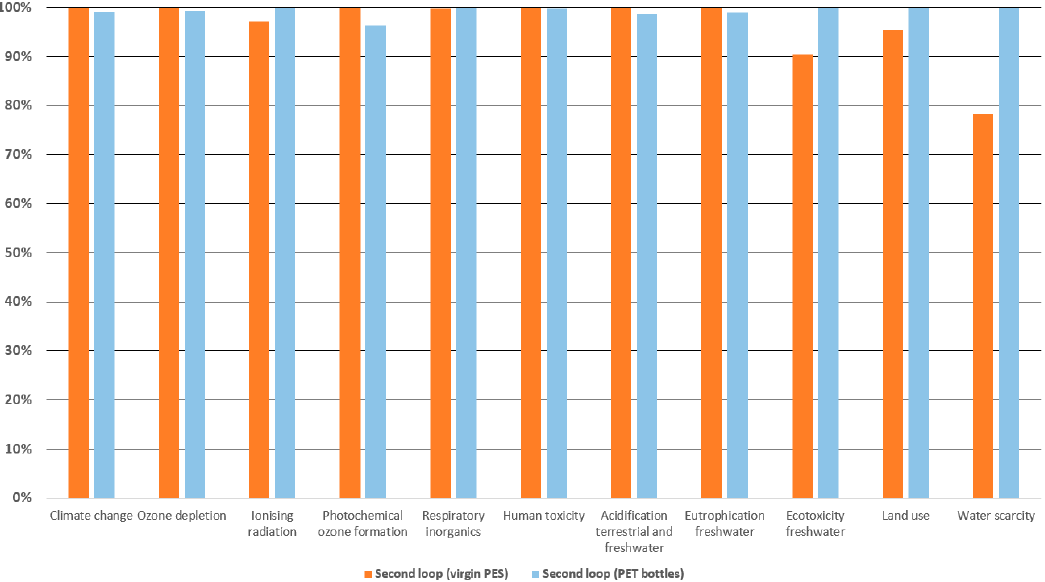
Figure 5. Impact comparison between the second loop product systems once with virgin PES and once with PET bottles as the main input for fiber production.